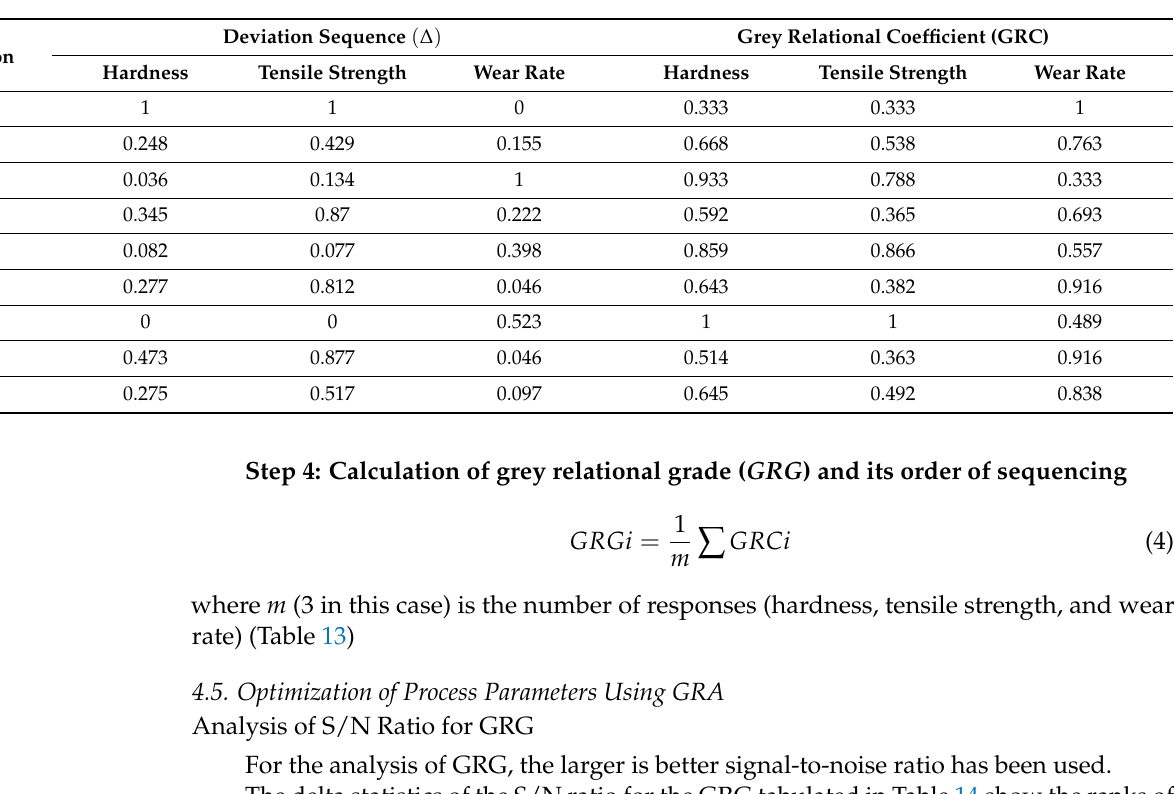
Table 12. Deviation sequence and GRC of responses with ∂ =